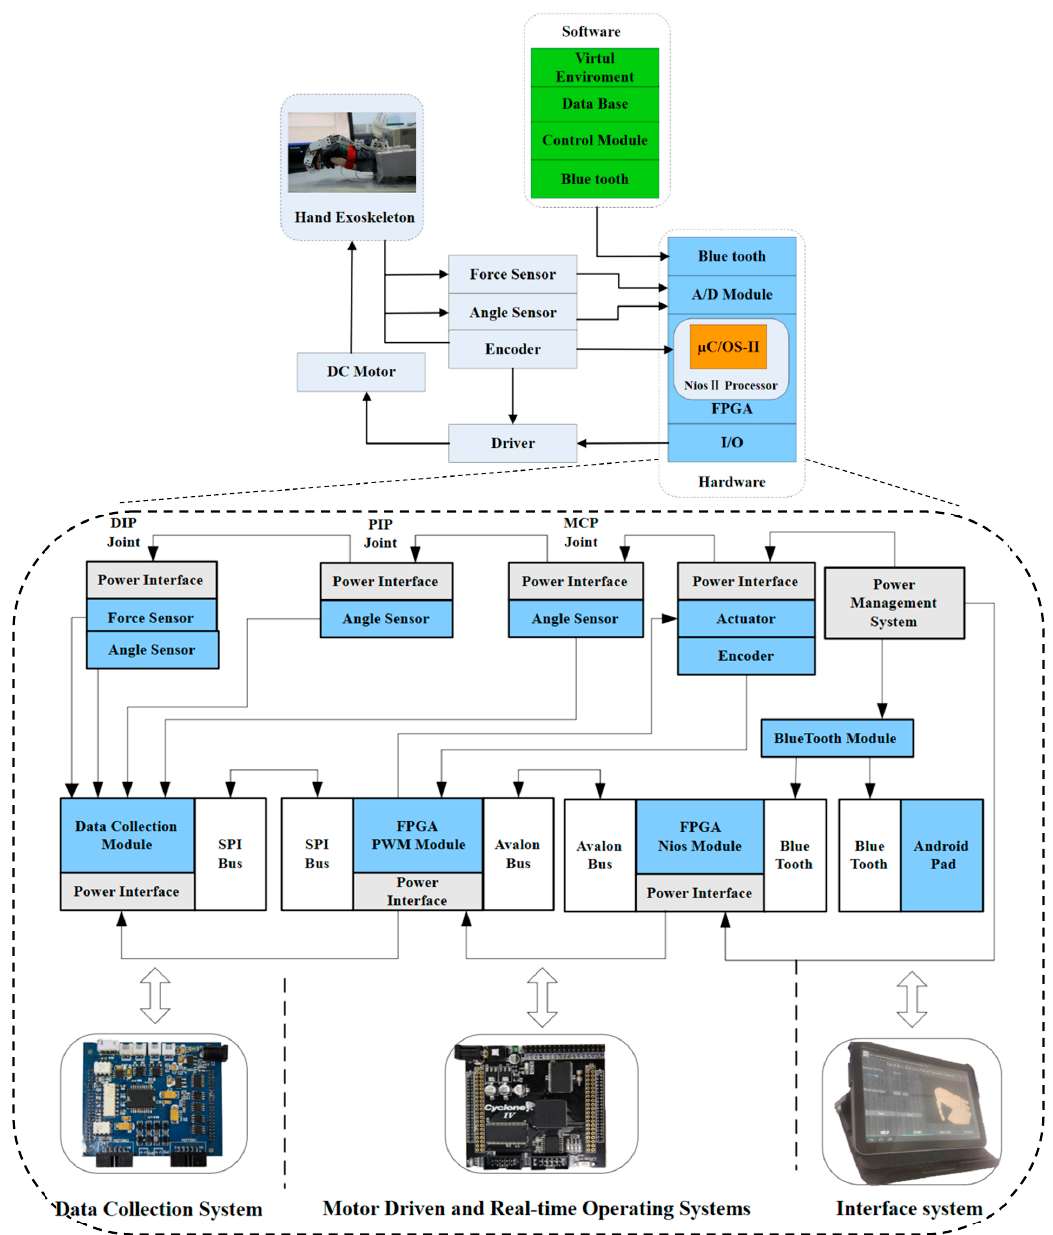
Figure 2. ( a ) Control system layout; ( b ) the control hardware composition.